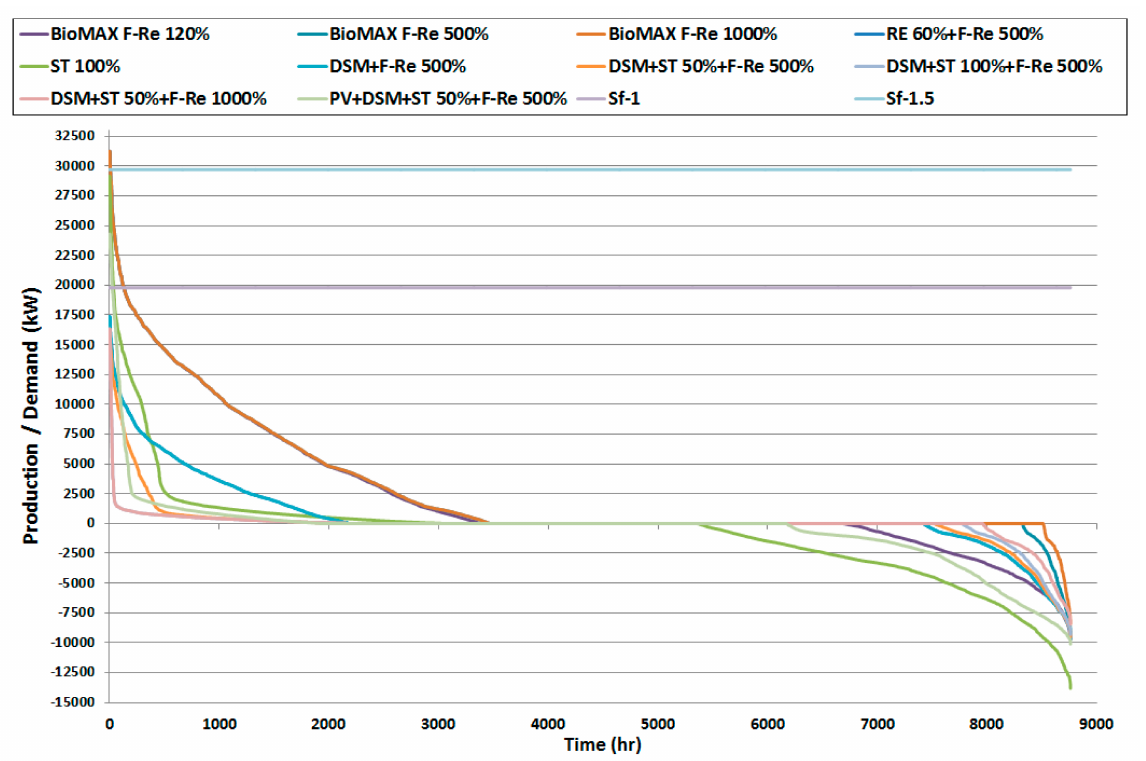
Figure A13. Main yearly results from the BioMAX scenarios.